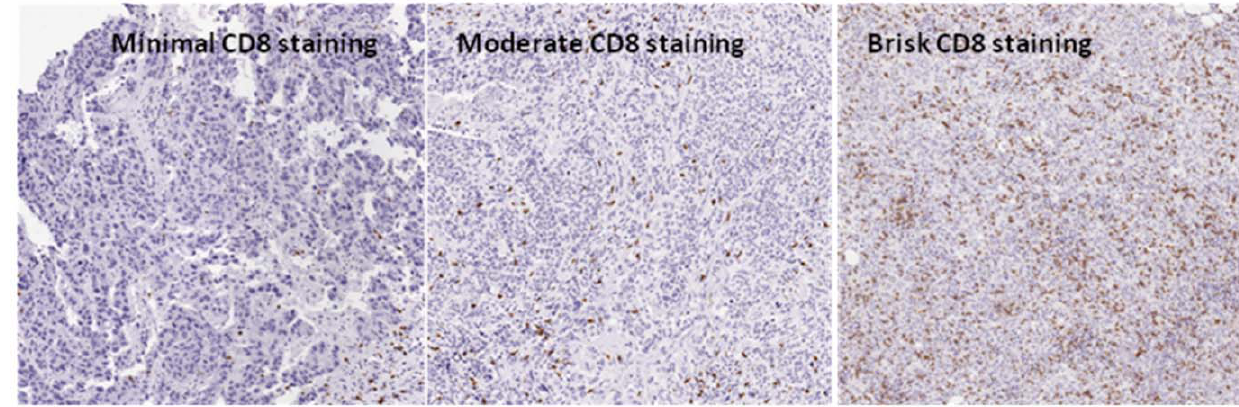
Figure 4. Extent of CD8 infiltration in triple negative tumors. This figure demonstrates the extent of CD8 infiltration in triple negative breast